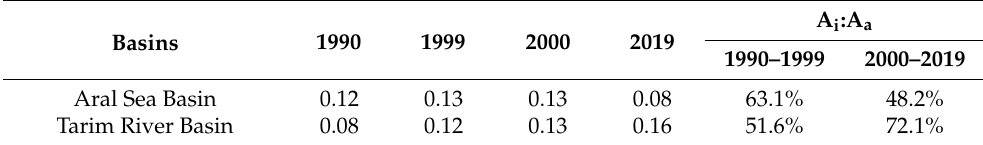
Table 1. Changes in the NDVI in the Aral Sea Basin and the Tarim River Basin, Central Asia, over different periods before and after EWC.